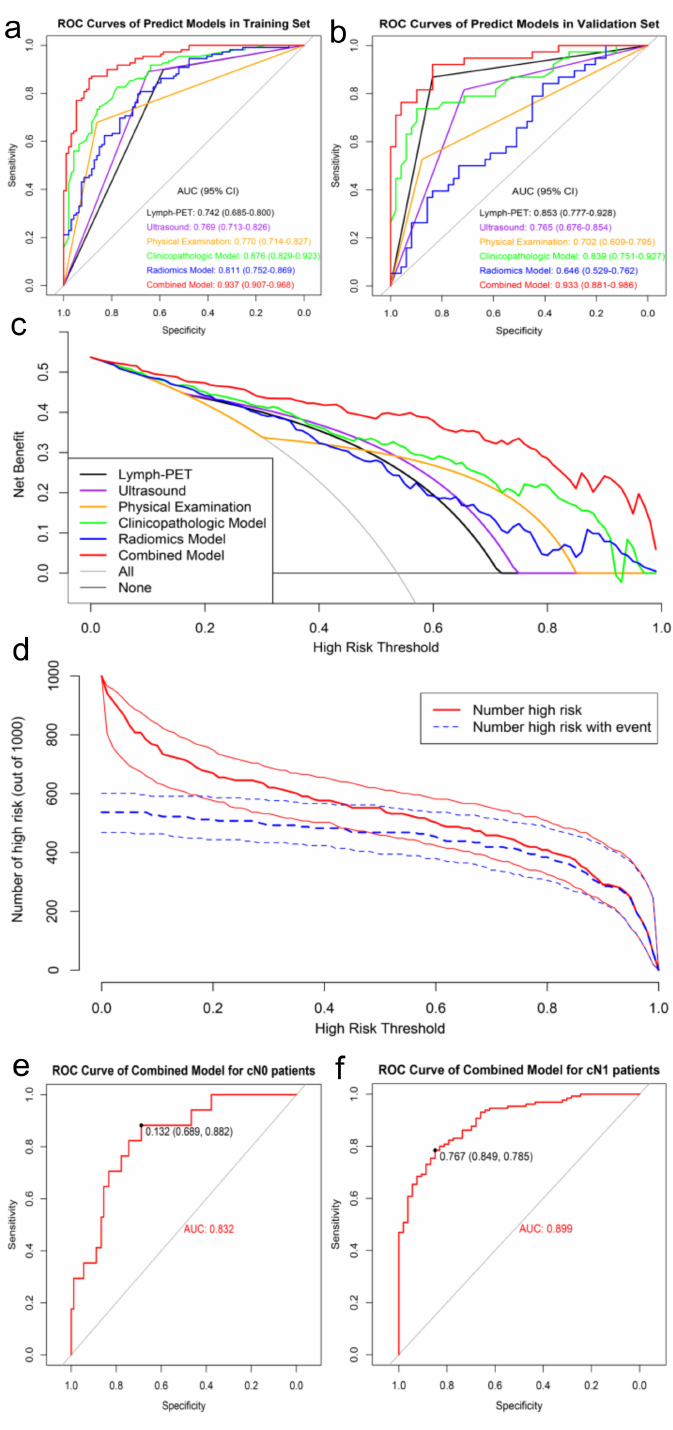
Figure 4. ROC analysis of predict models for predicting ALN status in the training set ( a ) and validation set ( b ), respectively. DCA of predict models in training set ( c ). The X-axis represents the threshold probability that the expected benefit of treatment was equal to the expected benefit of avoiding treatment. The Y-axis represents the net benefit. The gray and black line represent the hypothesis that all early-stage breast cancer patients were pN1 and pN0, respectively. CIC showed the Combined Model’s estimated number that would be declared high risk for each risk threshold and the proportion of true positive patients ( d ). ROC analysis of Combined Model in the total data ( e , f